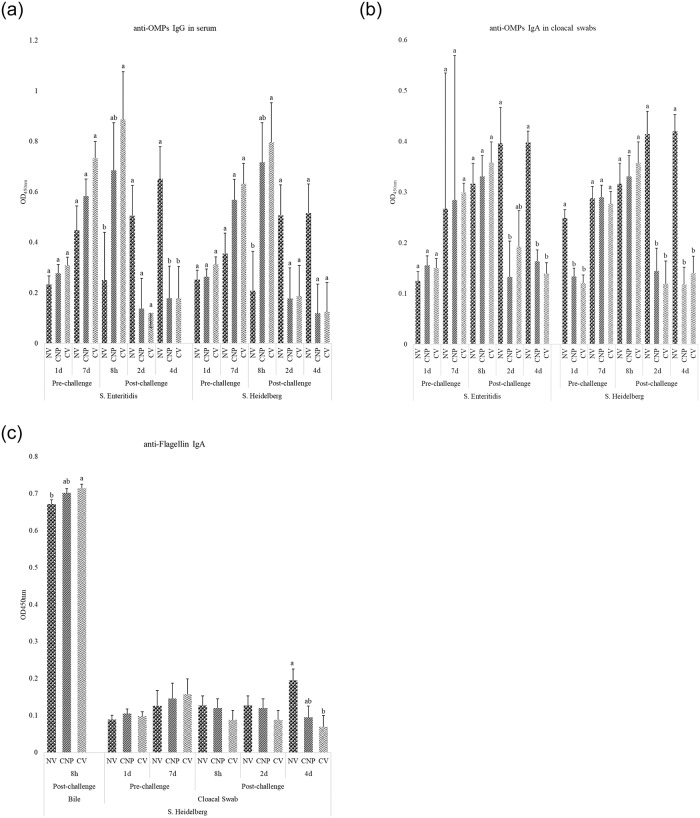
Effect of CNP-Salmonella vaccine on anti-S. Enteritidis or Heidelberg IgG and IgA antibody levels.At 1d of age, chickens were orally vaccinated with either PBS (NV), 1000 μg chitosan nanoparticle vaccine (CNP) or a commercial vaccine (CV). The same route of delivery and doses was repeated at 7d of age. At 14d of age, birds were challenged with 1 X 105 CFU/bird of either S. Enteritidis or S. Heidelberg. Blood, bile and cloacal swab samples were collected pre- and post-challenge and analyzed for anti-Salmonella antigen-specific IgG and IgA levels using ELISA. Results were reported as average optical density (OD) values. A–OMPs IgG; B–OMPs IgA; C–Flagellin IgA. Bars (+ SE) with no common superscript differ (P<0.05). n = 6.